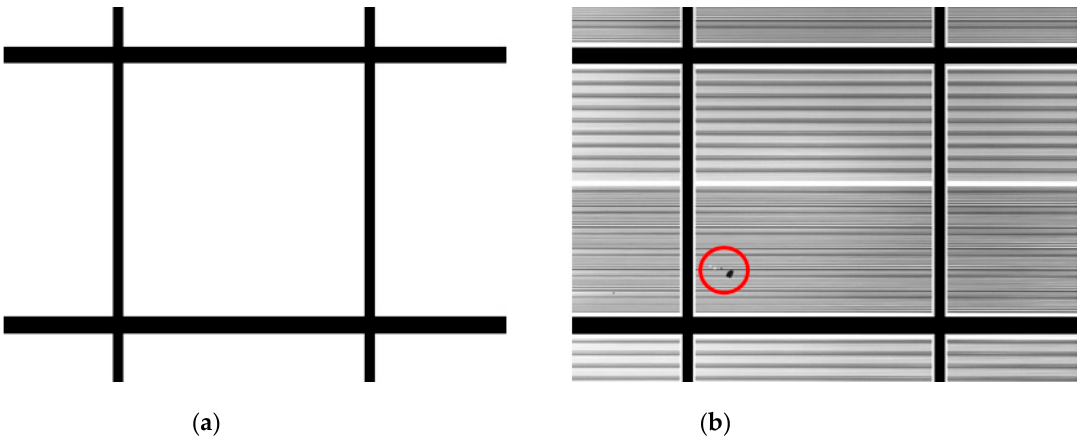
Figure 8. ( a ) The mask for the blocks. ( b ) The image of the blocks segmented using the mask in ( a ) and a defect is marked with a red circle.